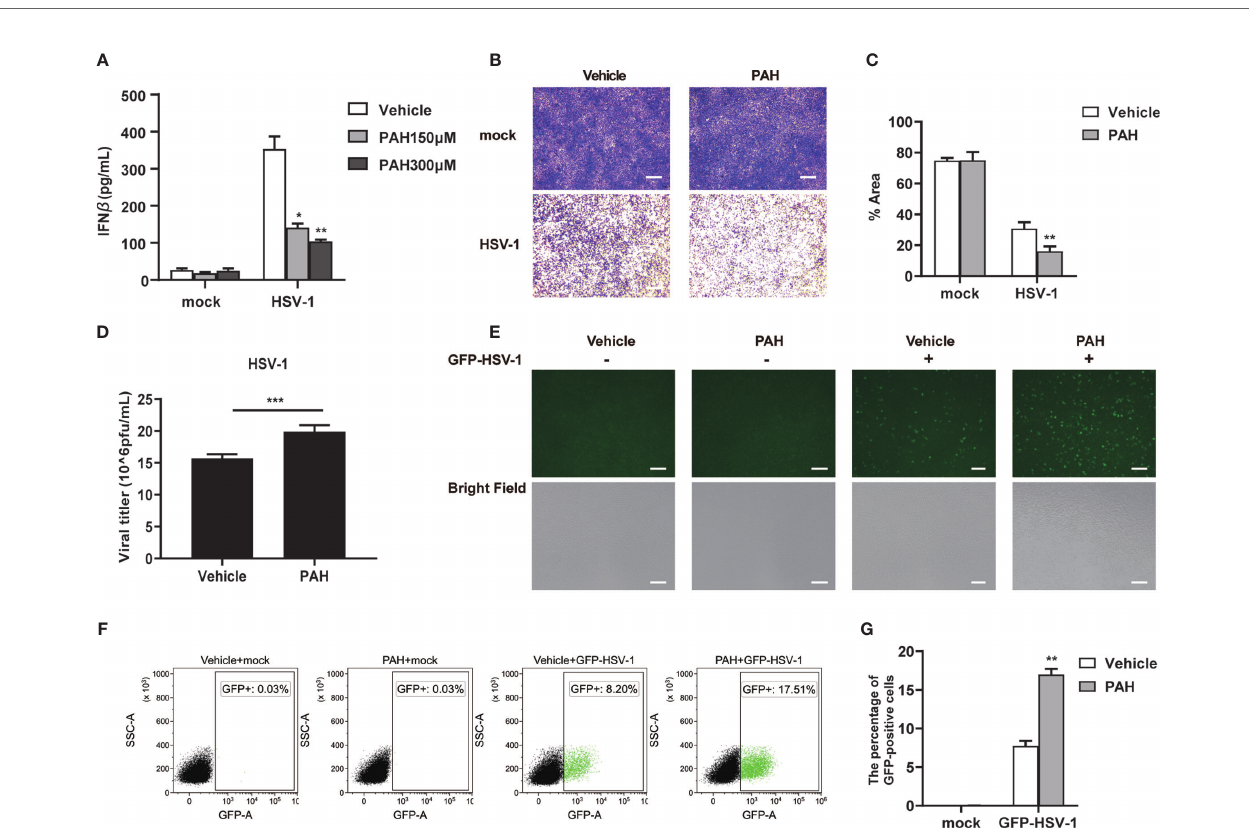
FIGURE 4 | PAH restricts the host innate defense against HSV-1 in vitro. (A) L929 cells were treated with Vehicle or indicated PAH concentrations for 6 h and then stimulated with HSV-1 (MOI = 1) for 9 h. The supernatants were collected, and ELISA determined the amounts of IFN- b . (B) L929 cells were treated with Vehicle or PAH (200 m M) for 6 h and then infected with HSV-1 (MOI = 1). The proliferation of cells was examined by crystal violet staining. Scale bars represent 100 m m. (C) The statistical analysis of stained cell ratios from (B) . (D) L929 cells were treated with Vehicle or PAH (200 m M) for 6 h and then infected with HSV-1 (MOI = 1). The titers of HSV-1 were determined by standard plaque assay. (E) L929 cells were treated with Vehicle or PAH (200 m M) for 6 h and then infected with GFP-HSV-1 (MOI = 0.3) for 16 h. GFP-HSV-1 replication was visualized by fl uorescence microscopy. Scale bars represent 100 m m. (F) L929 cells were treated with Vehicle or PAH (200 m M) for 6 h and then infected with GFP-HSV-1 (MOI = 0.3) for 16 h. GFP-HSV-1 replication was visualized by fl ow cytometry. (G) The statistical analysis of GFP-positive cell ratios from (F) . All of the experiments were repeated at least three times. Data in (A, C, D, G) are presented as mean ± SD. * P < 0.05, ** P < 0.01, *** P <